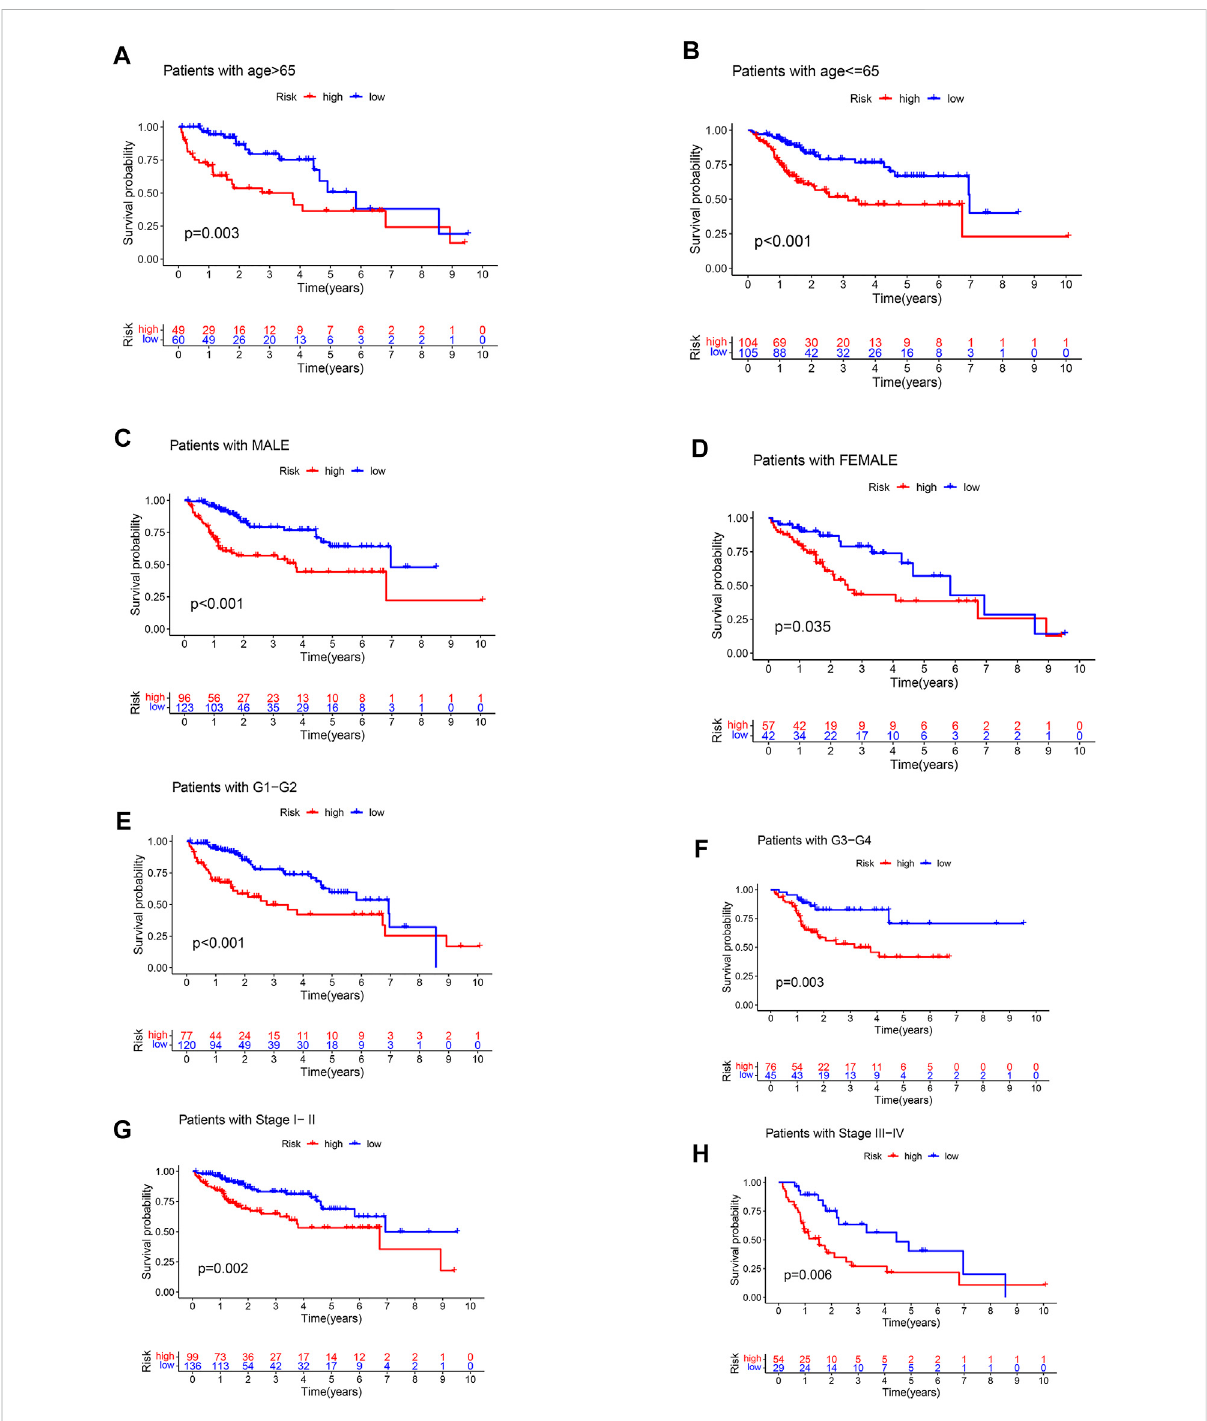
FIGURE 5 Clinicalstrati fi edsurvivalanalysis. (A) survivalanalysisofpatientswithage > 65. (B) survivalanalysisofpatientswithage < =65. (C) survivalanalysis ofmale patients. (D) survivalanalysisoffemalepatients. (E) survivalanalysisofpatientswithgrade1 – 2. (F) survivalanalysisofpatientswithgrade 3 – 4. (G) survival analysis of patients with stage I-II. (H) survival analysis of patients with stage